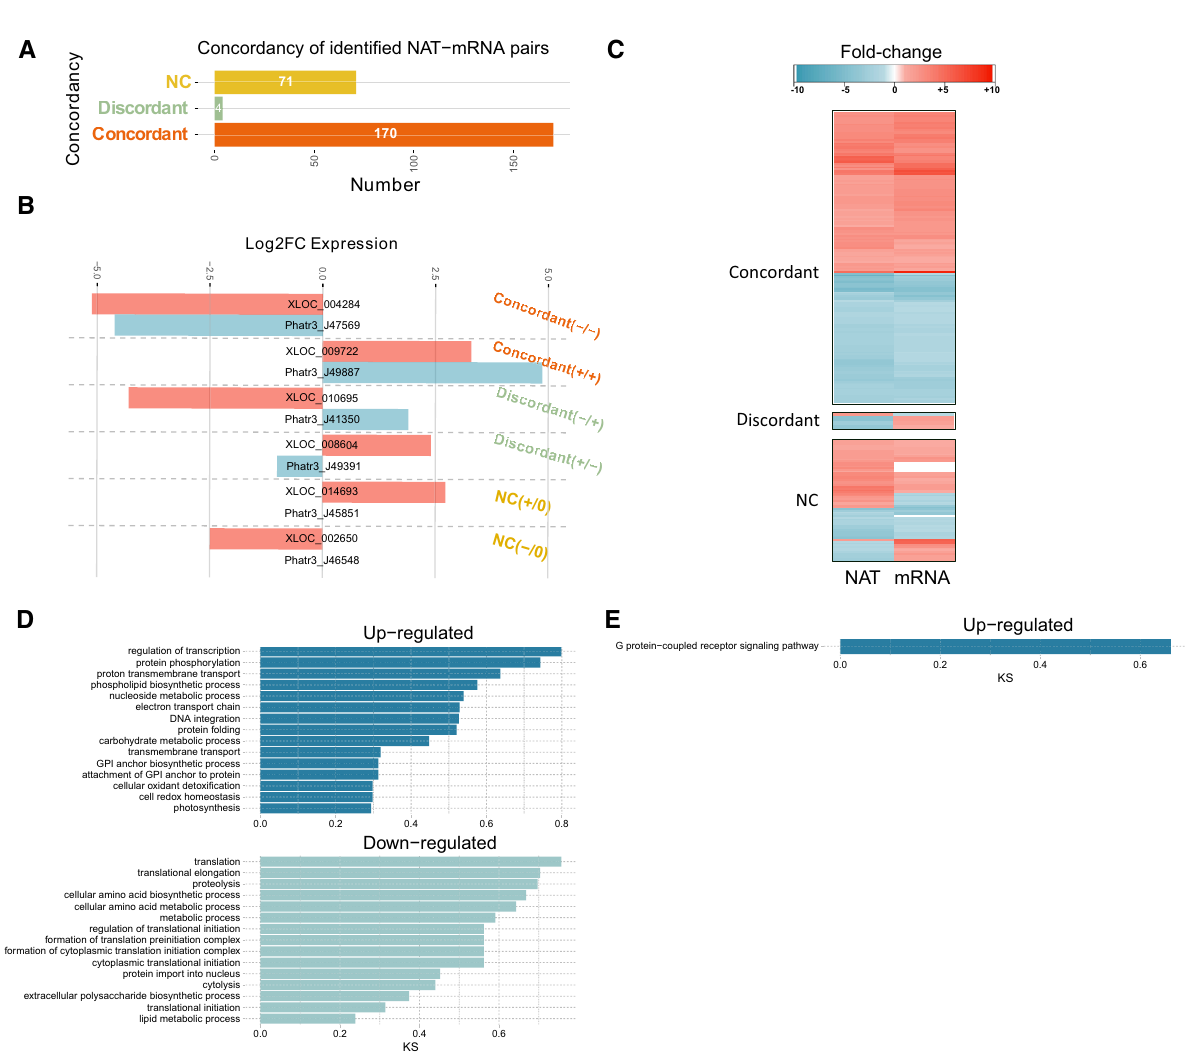
Figure 4. Characterization of the NAT-mRNA pairs detected in the Oval vs. the Fusiform pairwise comparison (OF). ( A ) Horizontal histogram showing the distribution of DE NAT-mRNA pairs according to the concordancy of the NAT and the corresponding cognate mRNA transcript. NC, low/no correlation (R 2 ≤ 0.6) between NAT and its cognate mRNA. Discordant, NATs and their cognate mRNAs are DE with the opposite trend (one is upregulated while the other is downregulated), and Concordant, NATs and their cognate mRNAs are DE expressed with the same trend (negative or positive correlation), ( B ) fold expression change of two concordant, two discordant NAT-mRNA pairs, and one NC NAT-mRNA. ( C ) Heatmaps of log2 fold expression changes under morphotype change of the NAT-mRNA pairs (with positive and negative correlation) identified in P. tricornutum (R 2 ≥ 0.6, fold change ≥ 2 or ≤ 1/2, and Adjusted p value < 0.05). Biological Process GO enrichment analysis of ( D ) concordant and ( E ) discordant NAT-mRNA pairs. Figures were made using the “Wes Anderson” color palette “Zissou1” in R (https:// github. com/ karth ik/ wesan